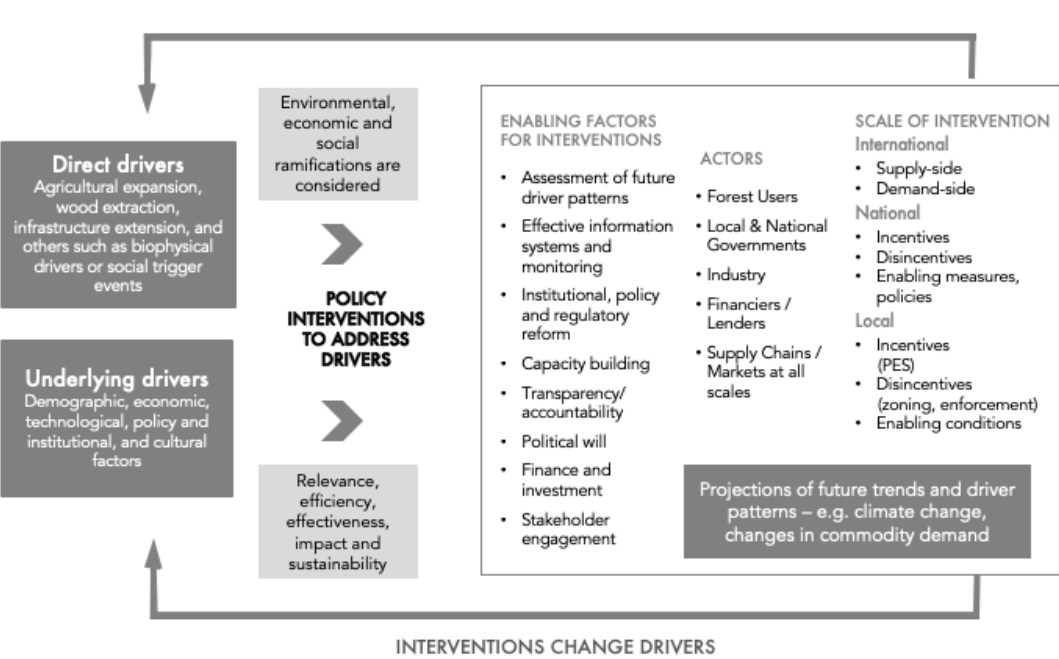
Figure 1. Drivers of land use change, interventions, actors and scales framework. Source: Adapted from Kissinger et al (2012) [16].